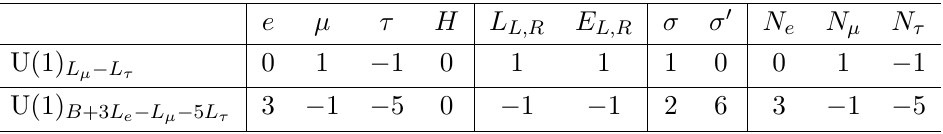
Table 4 . Charge assignment of gauged U(1) L considered in the model in appendix